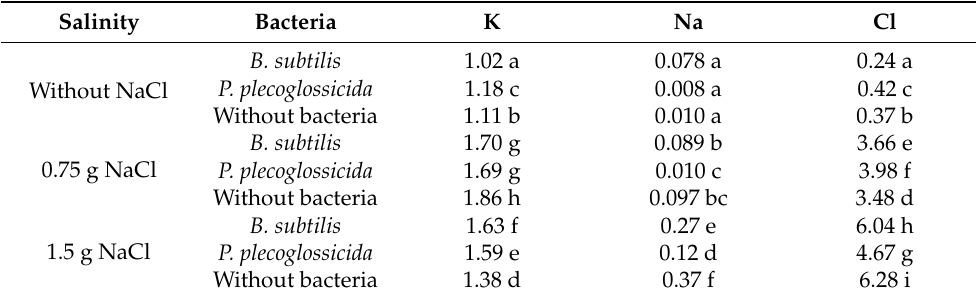
Table 3. Accumulation of saline ions in leaves of Persea americana var. Zutano inoculated with PGPR and induced to salinity stress.